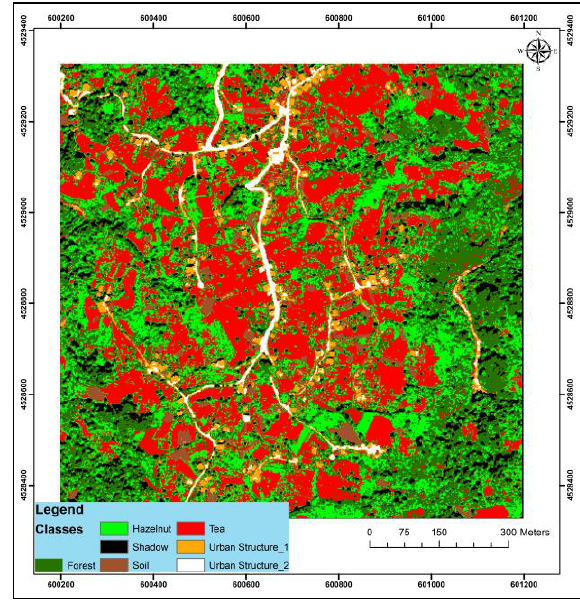
Figure 2. Produced thematic